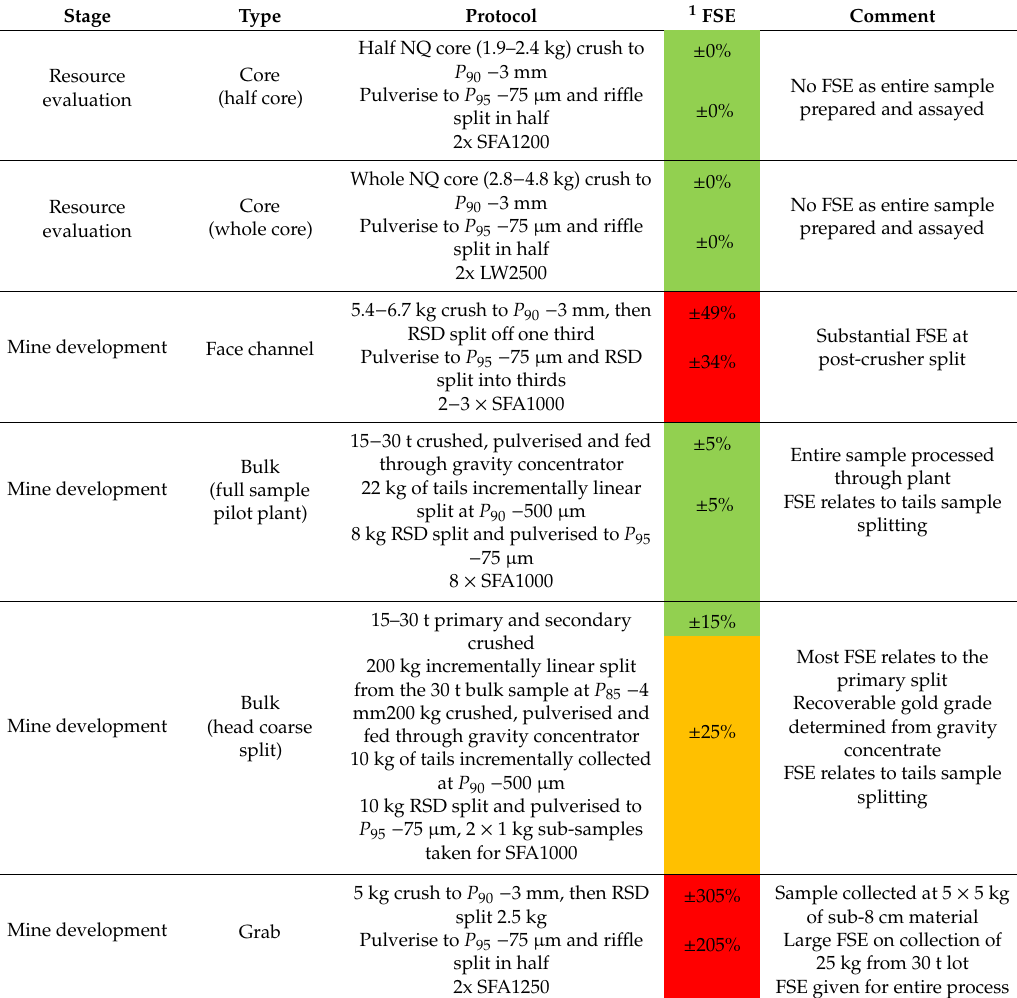
Table 22. Protocols and FSE for resource evaluation and mine development stages at San Christina. FSE calculations based on the BCOG and run of mine grade scenarios (Table 15). FSE calculations assume coarse gold in the pulp.